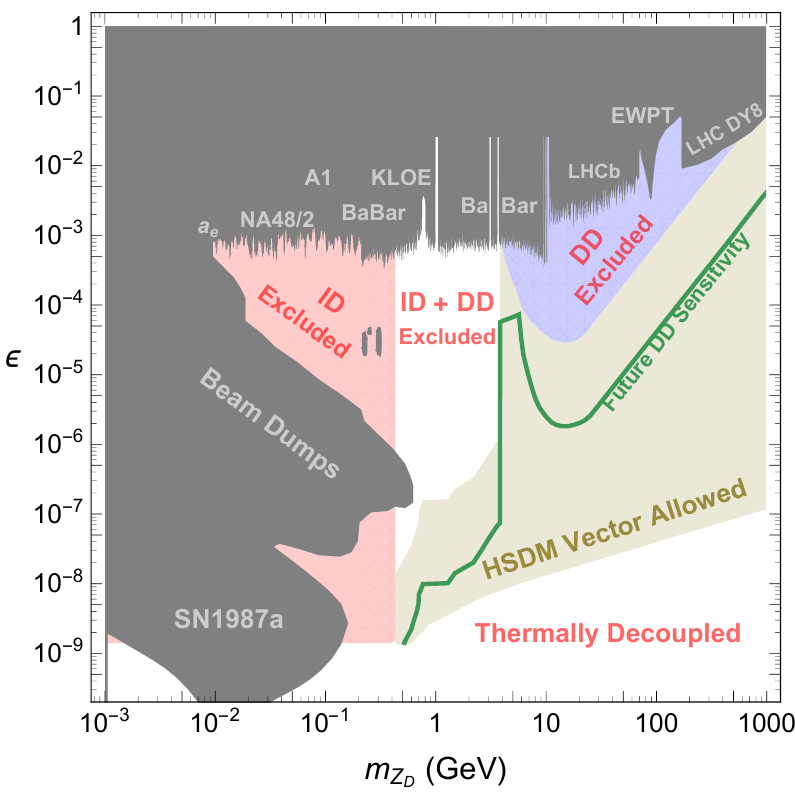
Figure 6 . Parameter space for WIMPs next door in the HSFO-VP model as a function of dark vector mass and portal coupling. In the red (blue) shaded regions, indirect (direct) detection alone excludes that point in f (cid:15); m Z g parameter space for all values of m (cid:31) > m Z D all values of m (cid:31) > m Z are excluded by a combination of direct and indirect detection. The future D direct detection sensitivity is determined by assuming CRESST-III Phase 2 and DARWIN ((cid:12)gure 3) are placing their nominal